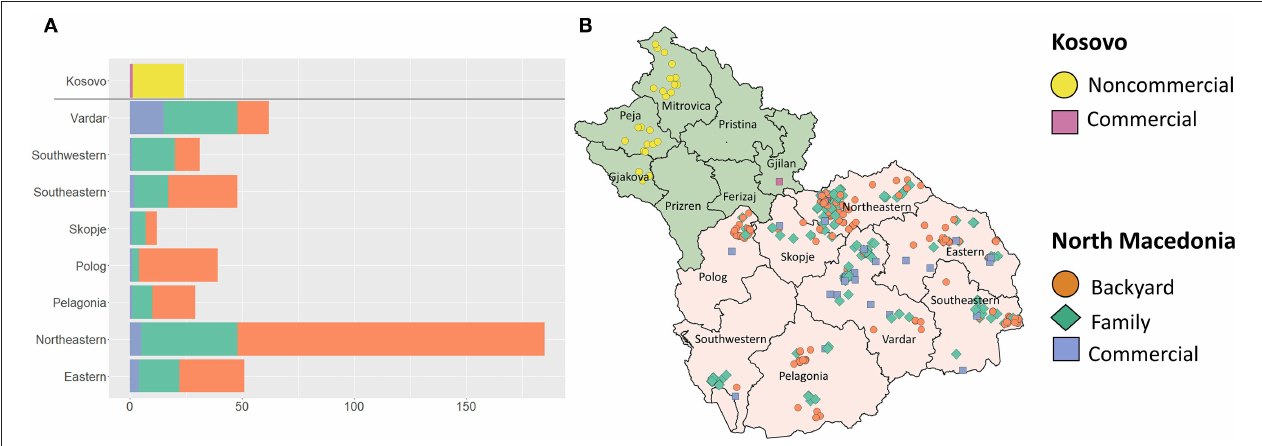
FIGURE 1 | (A) Number of questionnaires administered to North Macedonian pig producers by region and type of farm, and Kosovar producers characterized as commercial or non-commercial, during September 2019-March 2020. (B) Map of questionnaire sites by farm type. Kosovo: green, North Macedonia: orange. Kosovo districts and North Macedonia Regions: black